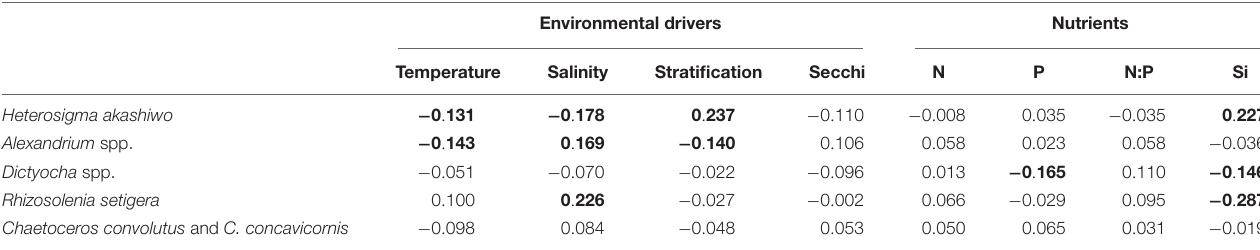
Environmental drivers Nutrients Temperature Salinity